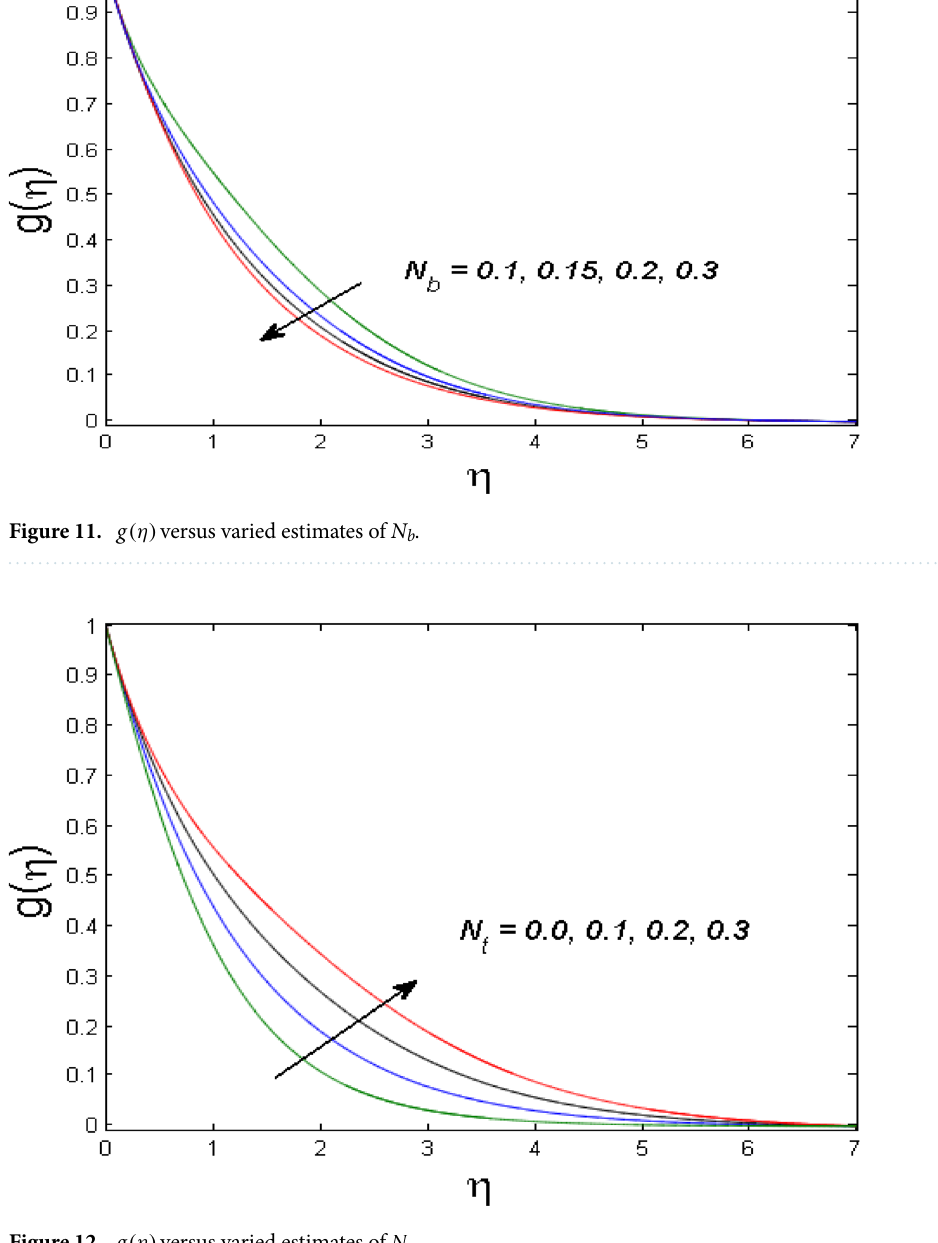
Figure 12. g (η) versus varied estimates of N t